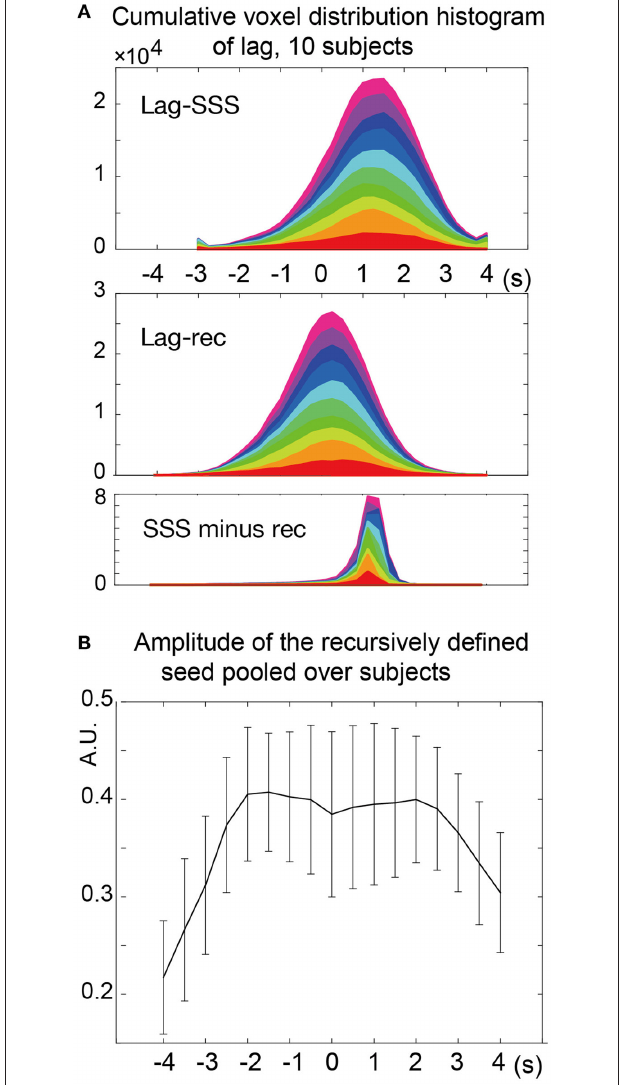
FIGURE 5 | Analysis of the lag maps. (A) Voxel frequency histogram of the two lag maps and their difference map. The narrow shape of the difference map histogram suggests a common lag structure detected by the two algorithms. Colors represent the 10 subjects. (B) Amplitude (standard deviation) of the recursively defined reference time courses. There was a reduction in the lag-encoding component magnitude beyond 2s in both up- and down-stream directions, suggesting loss of